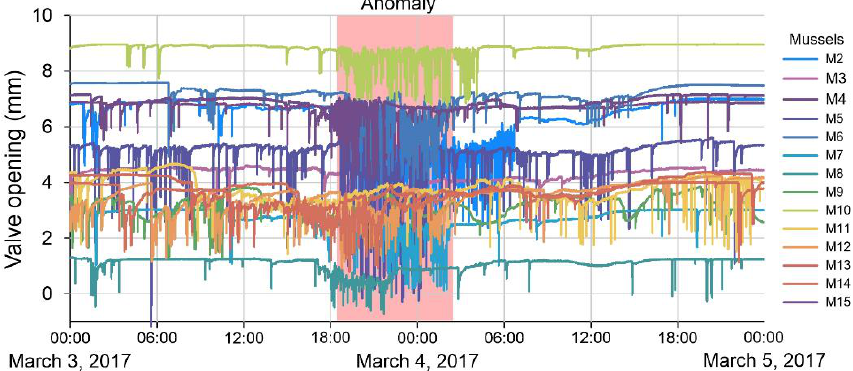
Figure 2. An example of the raw data on the activity of bivalves with anomaly (March 2017, Cher- naya River).